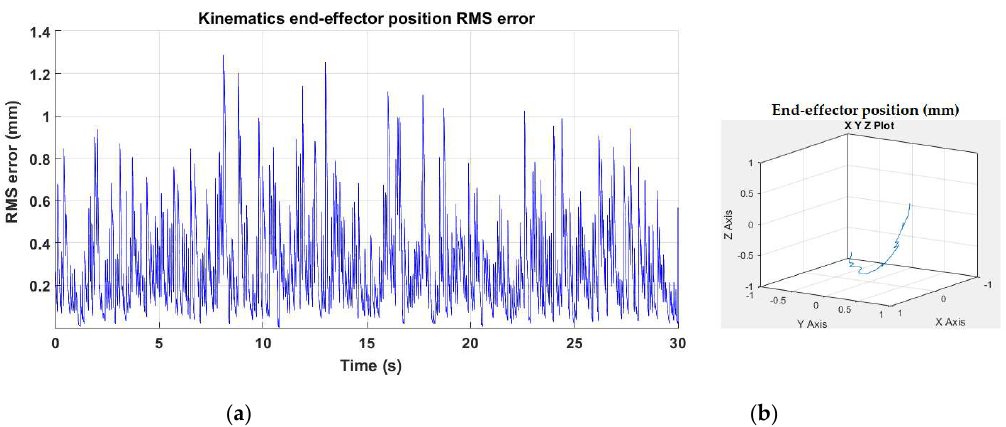
Figure 20. Sensor fault condition: ( a ) kinematics end-effector position RMS error and ( b ) end effector position in the XYZ plot.